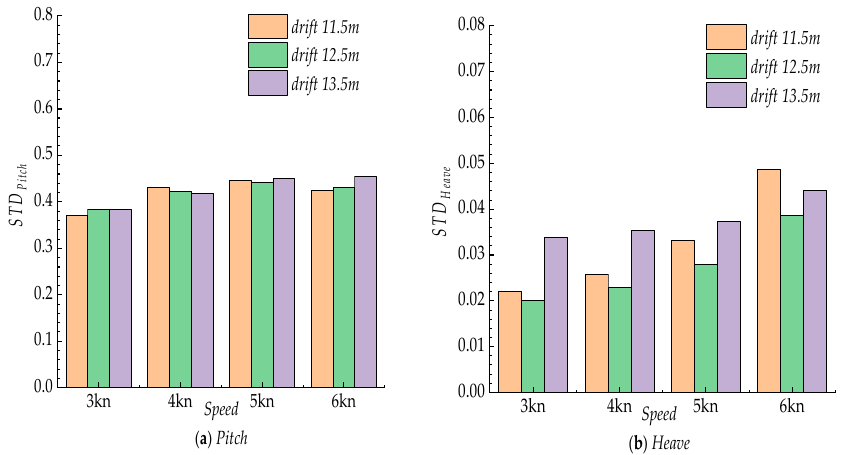
Figure 11. STD of dynamic responses for different drift depths and towing speeds.